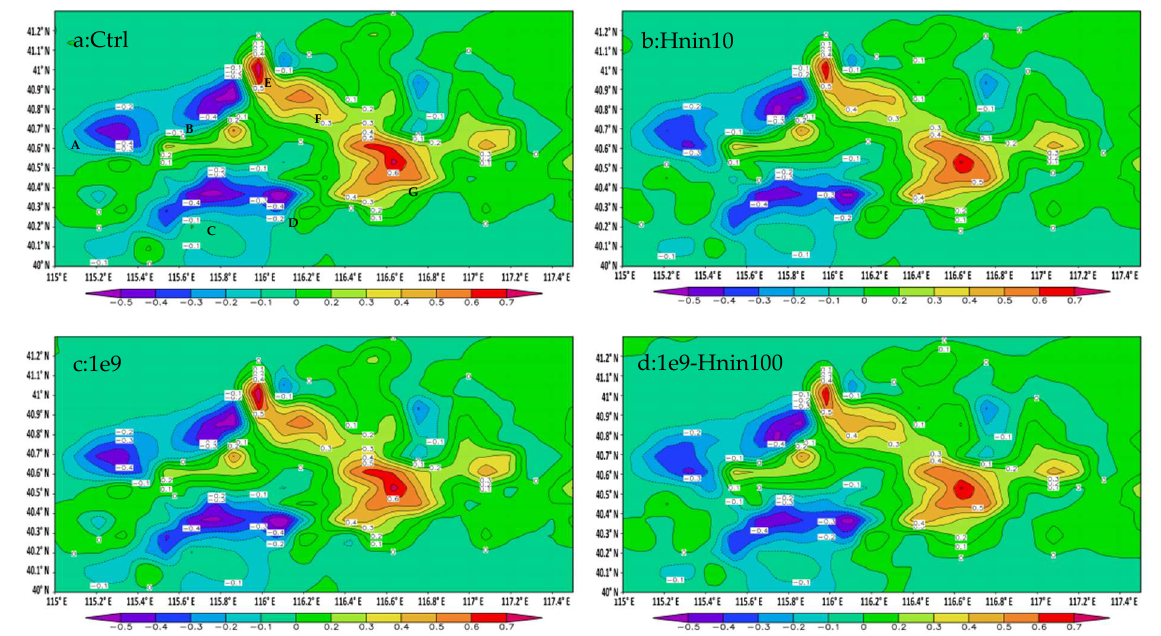
Figure 7. Daily precipitation distribution change of seeding and without seeding simulations (Ps-P) of control, Hnin100, 1e9, and 1e9-Hnin100. ( a ) Letters A, B, C, and D represent the four decreasing centers, and letters E, F, and G represent the three increasing centers.